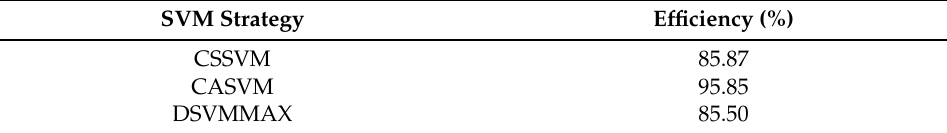
Figure 13. Switching and conduction losses of the DCM-232 inverter under the three SVM strategies. Table 4. Efficiency of the